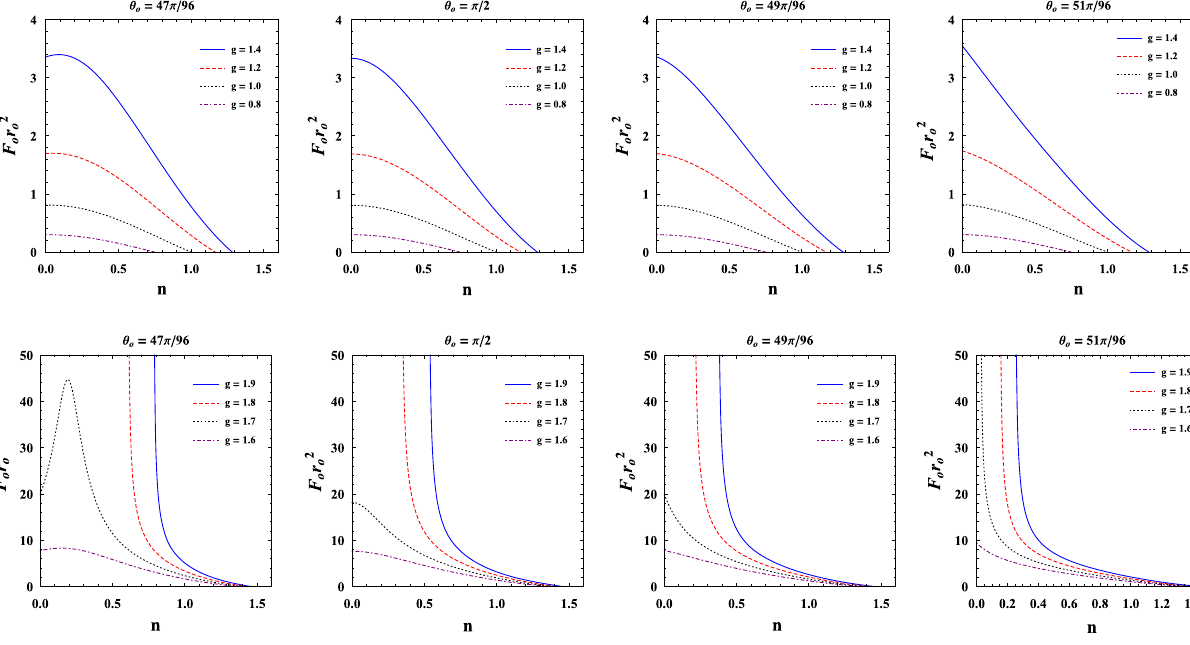
Fig. 6 The change of the flux F o at observer with the NUT charge n for different redshift factor g and the observer’s angular position θ o as the source lies in the NHEKTN line. Here, we set M =